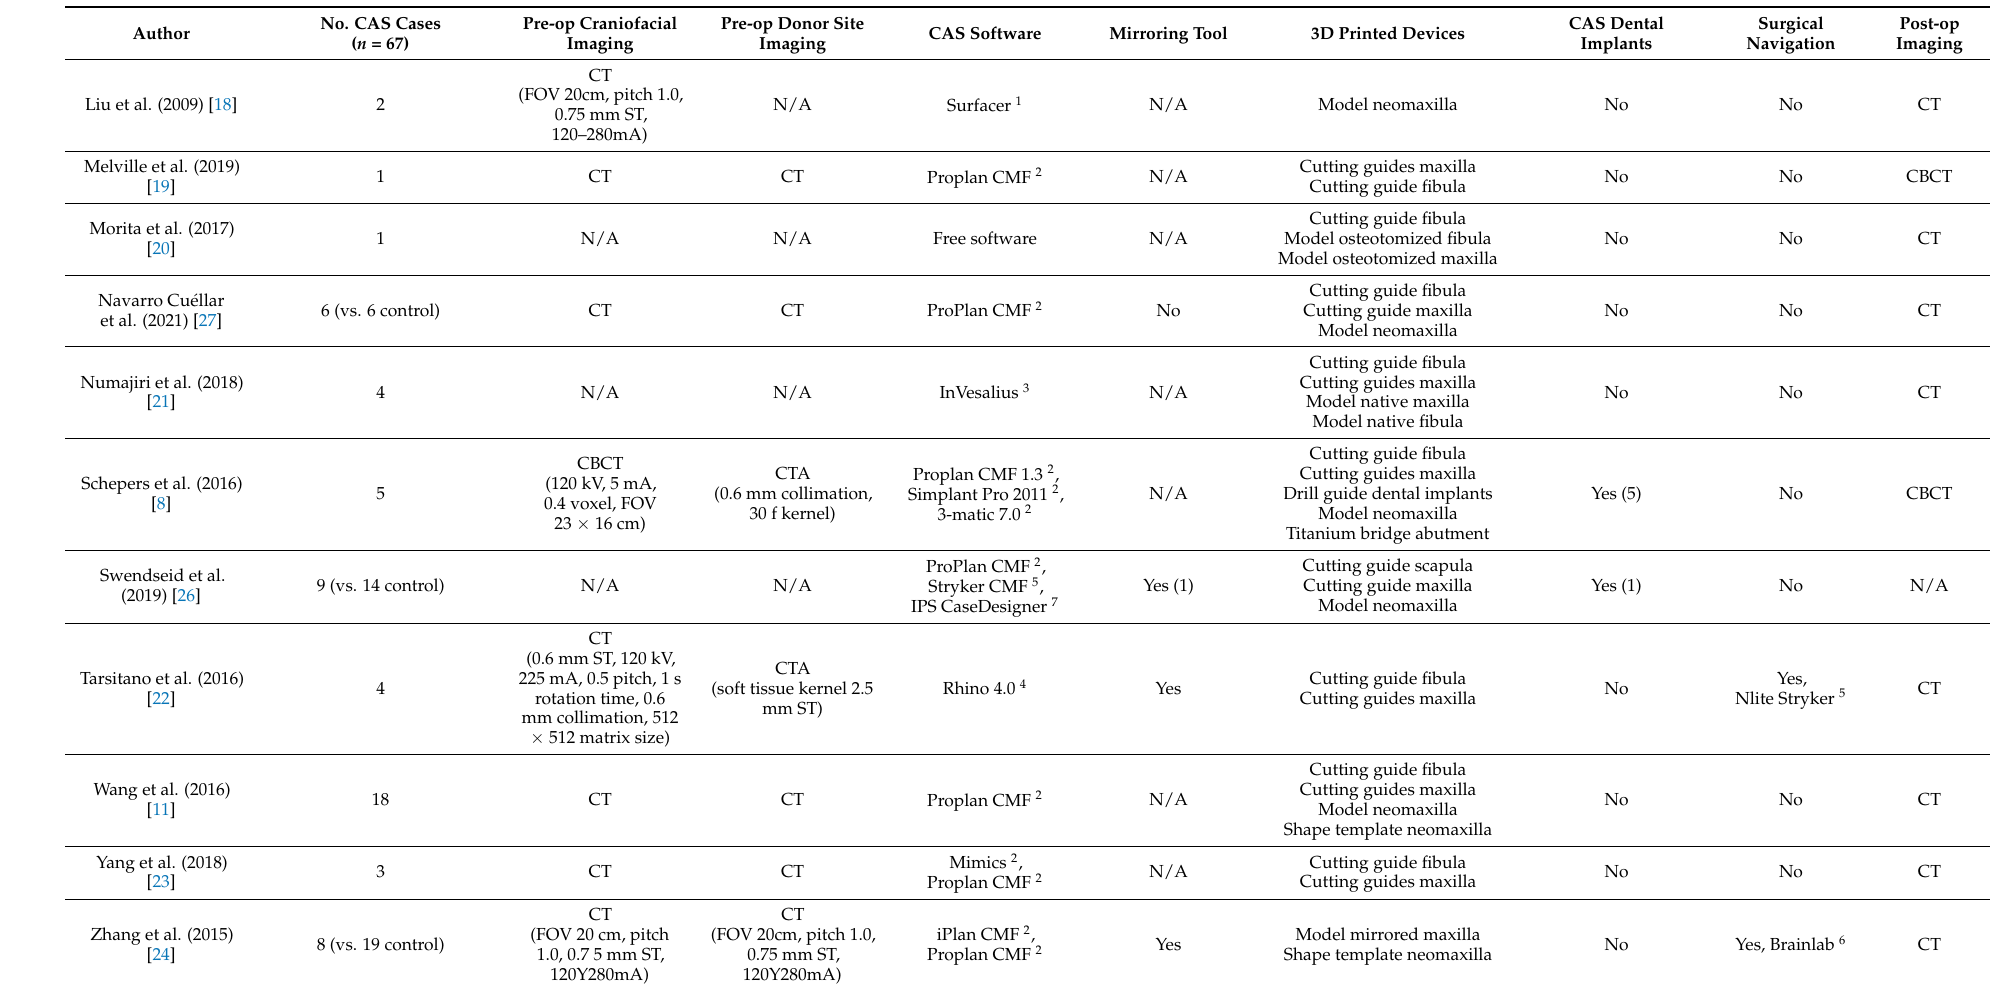
Table 2. CAS process of the included